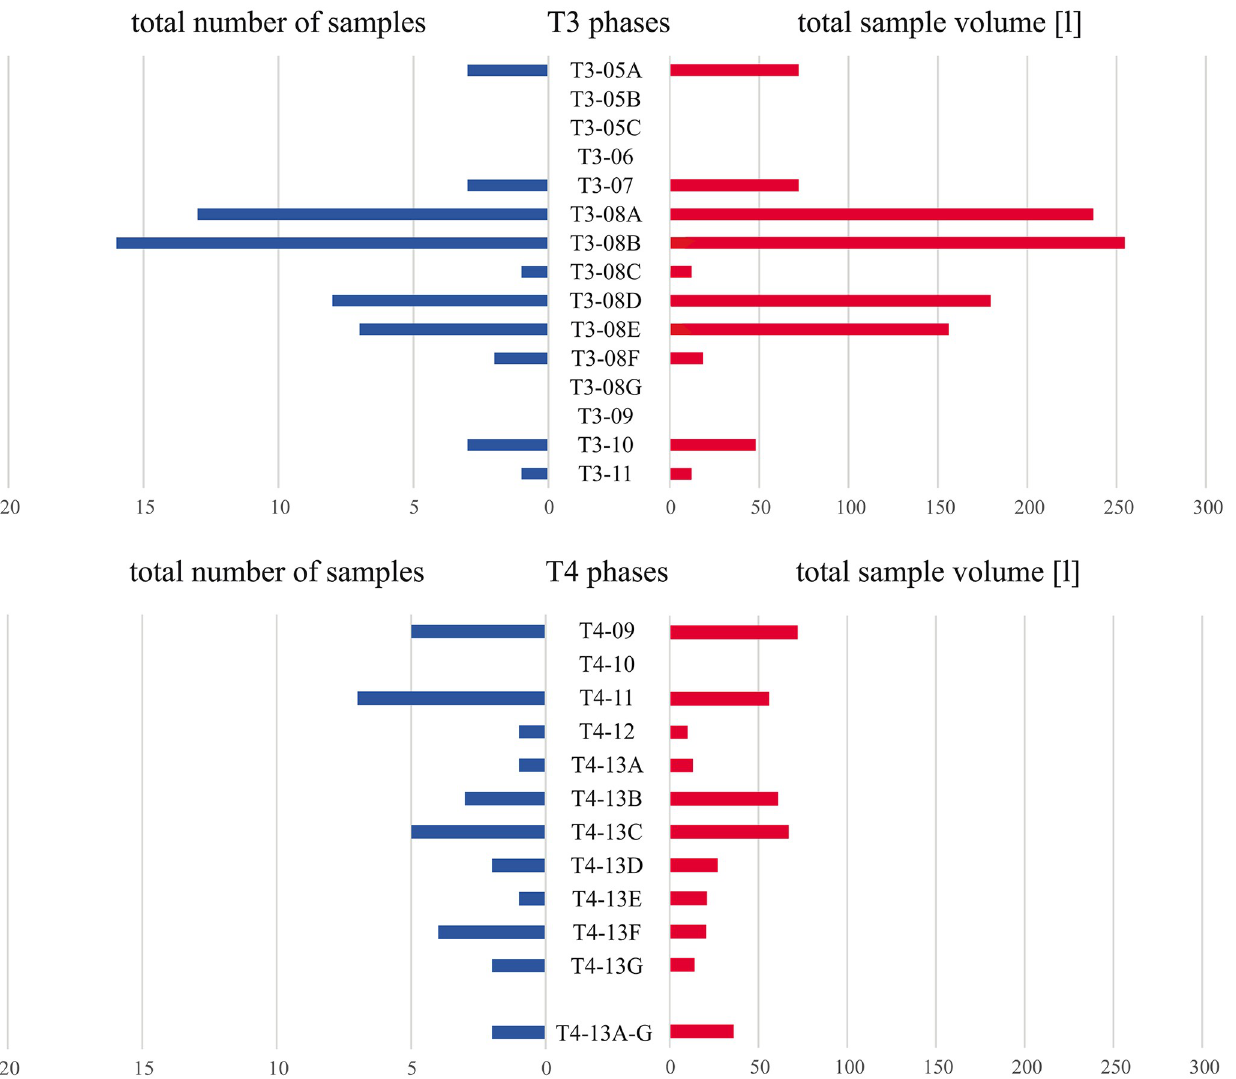
Fig 9. Representation of the Late Bronze Age phases of a) terrace T3 and b) terrace T4 in the sample material. For detailed values, please refer to the raw data in S1 Table. Image: OeAW-OeAI/A. G. Heiss.